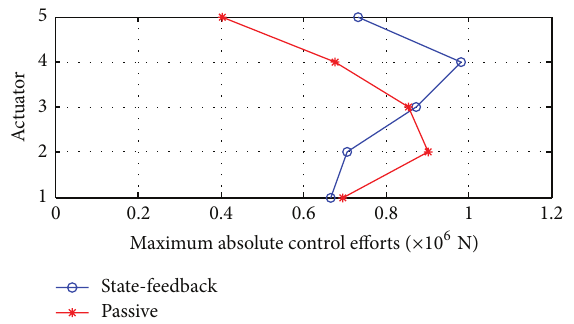
Figure 5: Maximum absolute interstory drifts corresponding to the uncontrolled building (black line with rectangles), the ideal state- feedback energy-to-peak controller defined by the gain matrix (blue line with circles), and the passive-damping system defined by ̃𝐾 the gain matrix 𝑑 (red line with asterisks). The full scale North- South El Centro 1940 seismic record has been used as ground acceleration disturbance.